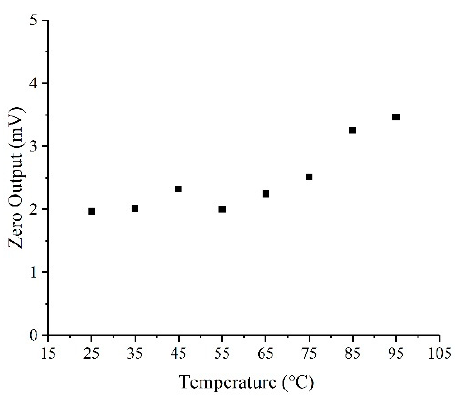
Figure 8. Zero output with different temperatures. Table 1. Specifications of the miniature pressure sensor.